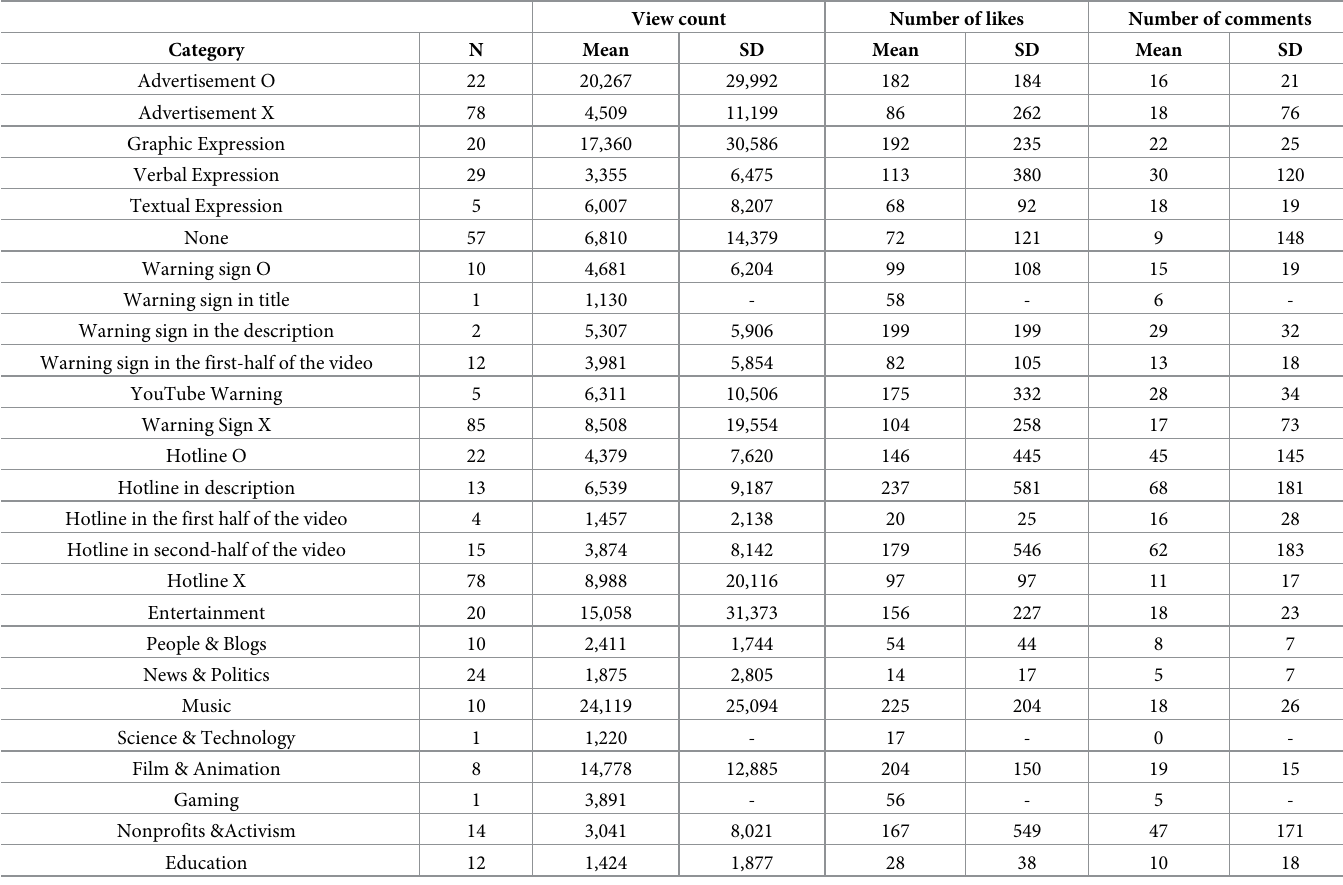
Table 3. Descriptive statistics for content expression characteristics